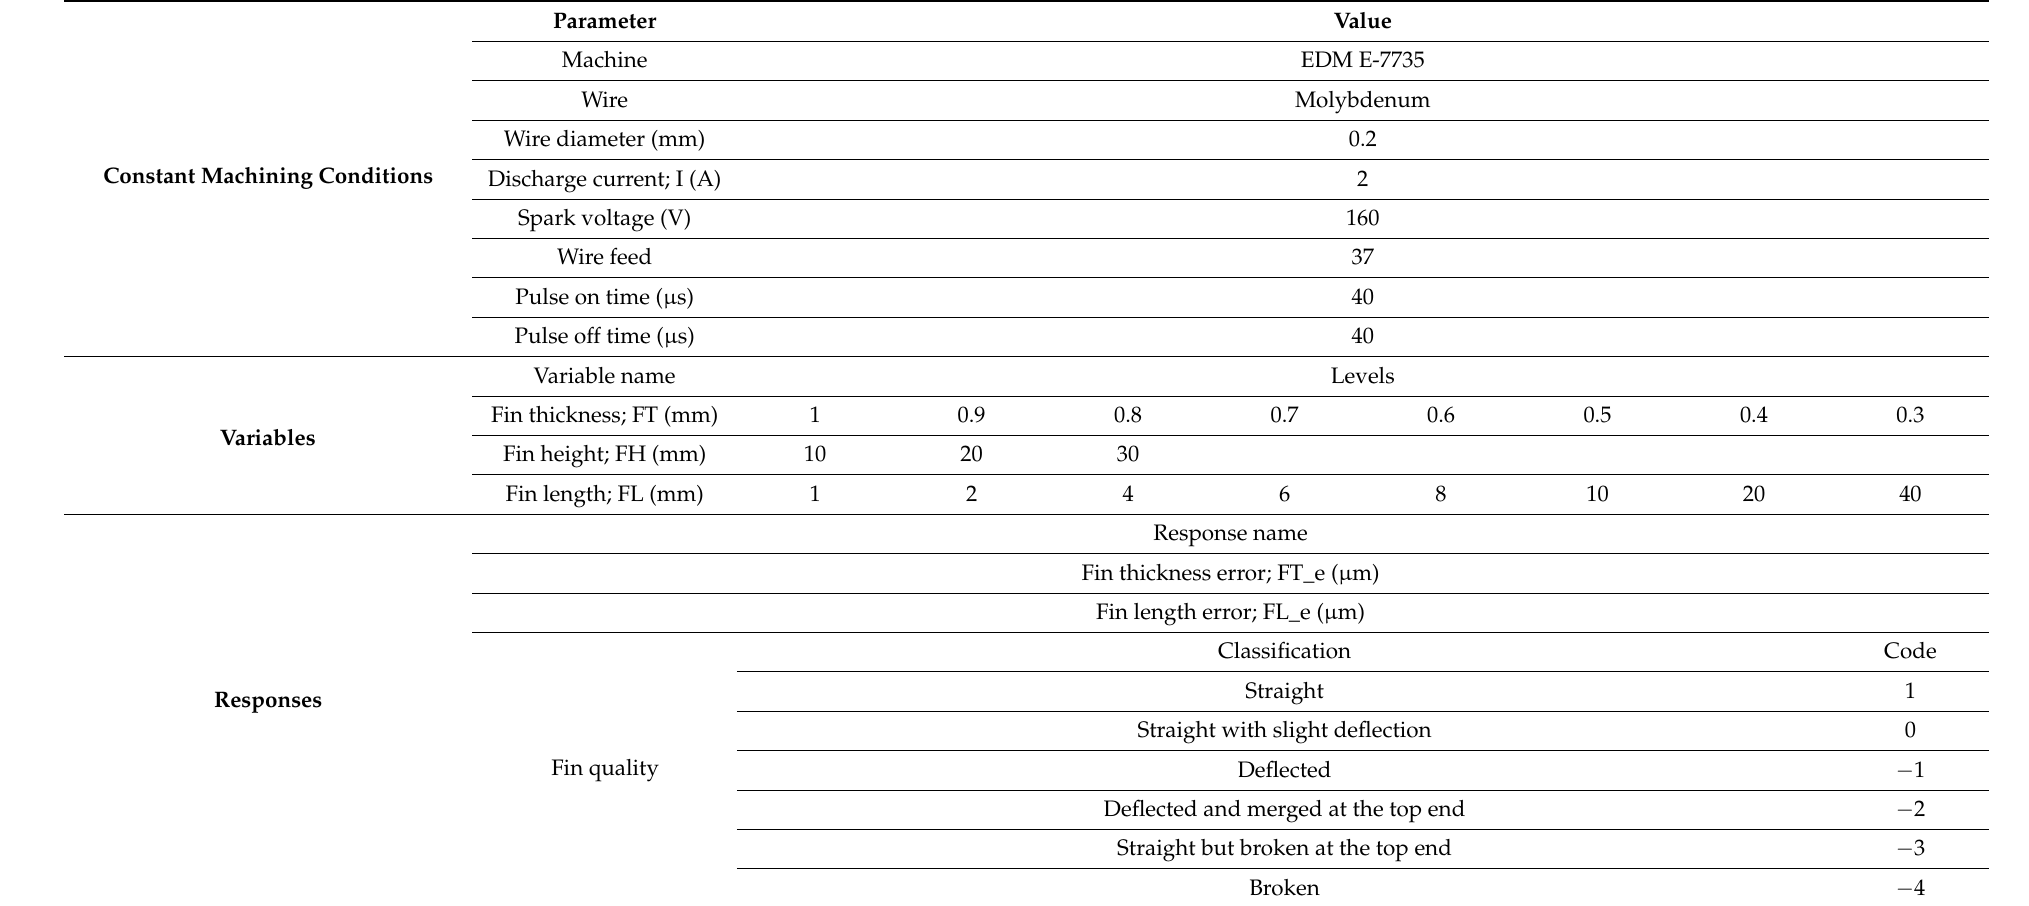
Table 3. Constant machining conditions, variables, and responses set to cut thin structures in D2